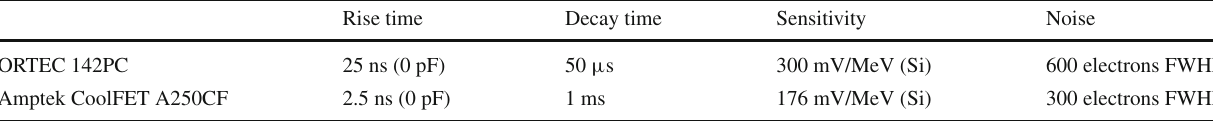
Table 1 General characteristics of the ORTEC preamplifier model 142PC and AMPTEK CoolFET preamplifier A250CF